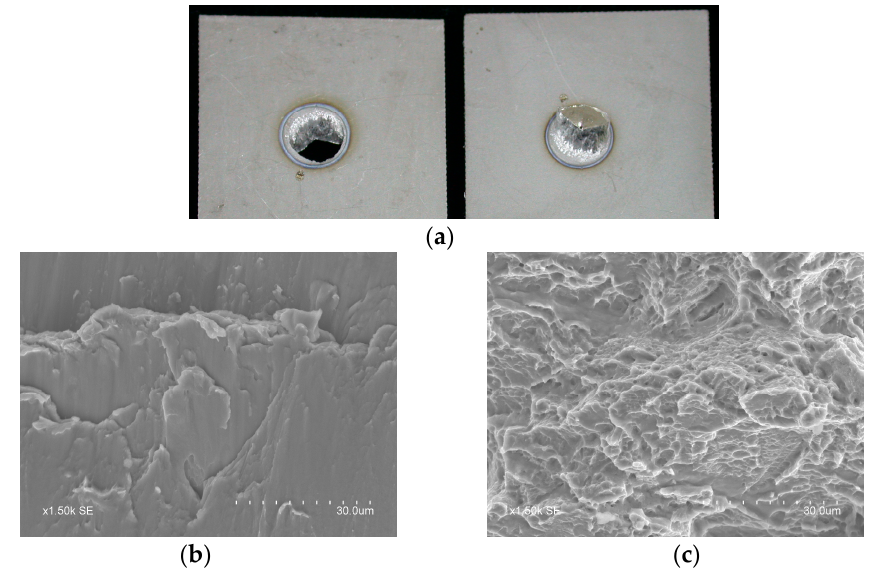
Figure 8. Partial interfacial failure mode: ( a ) Fracture appearance; ( b ) SEM (scanning electron microscopy) observation of the upper part of fracture surface. ( c ) SEM observation of the lower part of fracture surface.